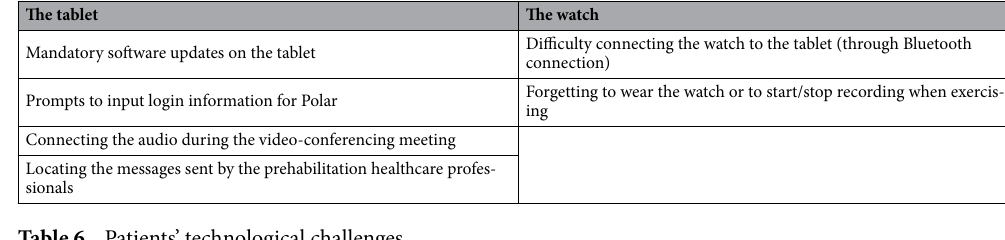
Table 6. Patients’ technological